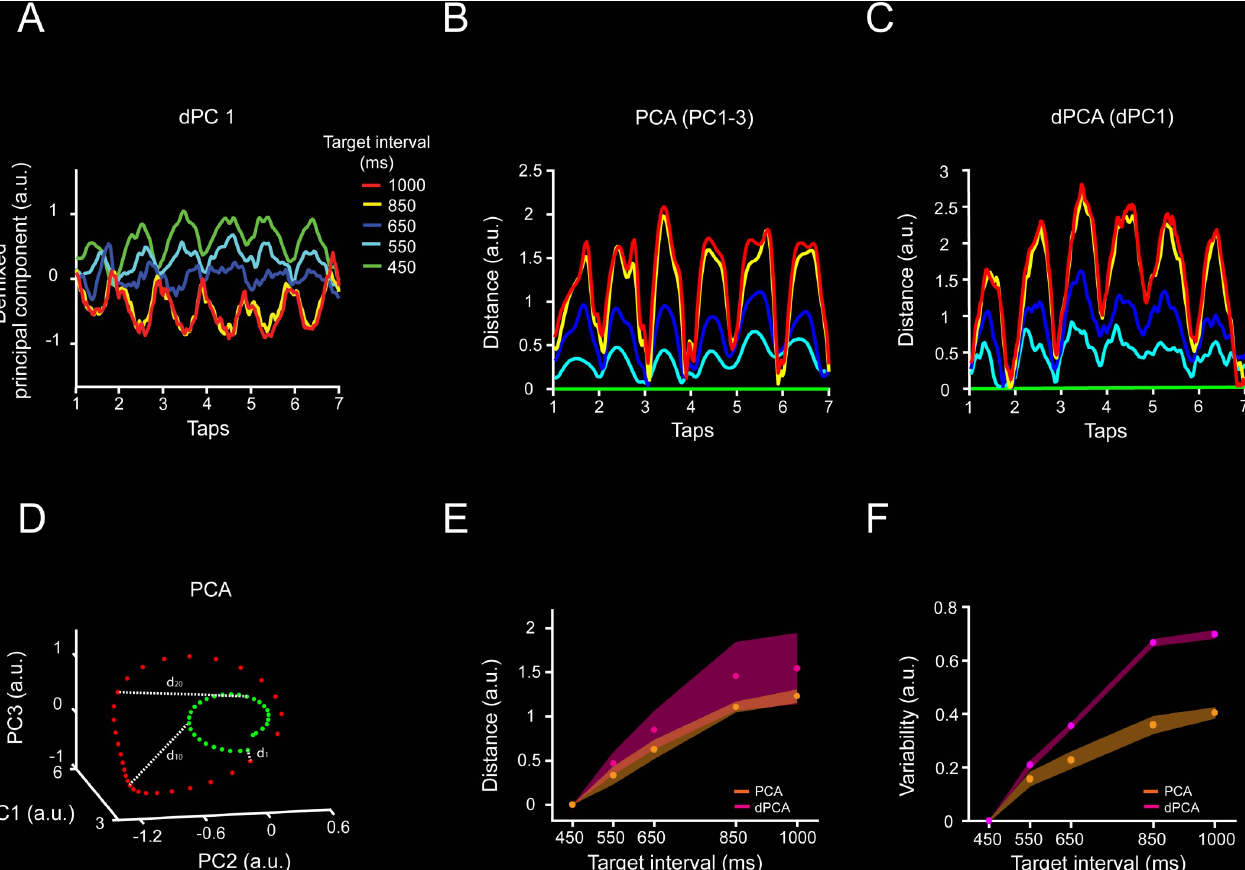
Fig 3. dPCA applied to neural population activity during SCT. A, dPC1 of the dPCA of the neural activity associated with the target interval (explains 7.8% of the total variance). Target interval in milliseconds is color coded (see inset A ). The neural trajectories show oscillatory activity, and their amplitude varies across target intervals. B,C. Euclidean distance between the first PC of the 450-ms target interval and the first PC of each target interval across time for ( B ) time- normalized PCA and ( C ) dPCA. Target interval is color coded as in ( A ). Two-sample Kolmogorov–Smirnov test on the distributions of PCA and dPCA distances showed nonsignificant differences ( p < 0.05) across target intervals. D. Distance calculation diagram for PCA data. The inter-tap trajectories for two target intervals are shown (green, 450 ms; red, 1,000 ms). The 450-ms target interval trajectory is used as the reference for distance calculation. The Euclidean distance between each sequential bin is calculated among the reference interval and the other target intervals trajectories. Both population analyses, PCA and dPCA, produced population signals with similar characteristics. Thus, oscillatory activity, modulation of the amplitude with the target interval, and an intersection close to the tap time are characteristics of the underlying neural population activity, irrespective of the dimension reduction algorithm. E. Mean inter-tap Euclidean distance (mean ± SD) between the 450-ms and each target interval for the PCA data using PC1–3, (orange) and dPCA using dPC1 (magenta). There was no significant difference between the slopes of PCA and dPCA (slope t test = 1.97, p = 0.0539) F. Variability of the distance between the 450-ms and each target interval for the PCA (orange) and dPCA (magenta). The variability increased monotonically as a function of the target interval for both analyses. Underlying data are available in https://doid.gin.g-node.org/d315b3db0cee15869b3d9ed164f88cfa/. a.u., arbitrary unit; dPCA, demixed PCA; PC, principal component; PCA, principal component analysis; SCT, synchronization-continuation